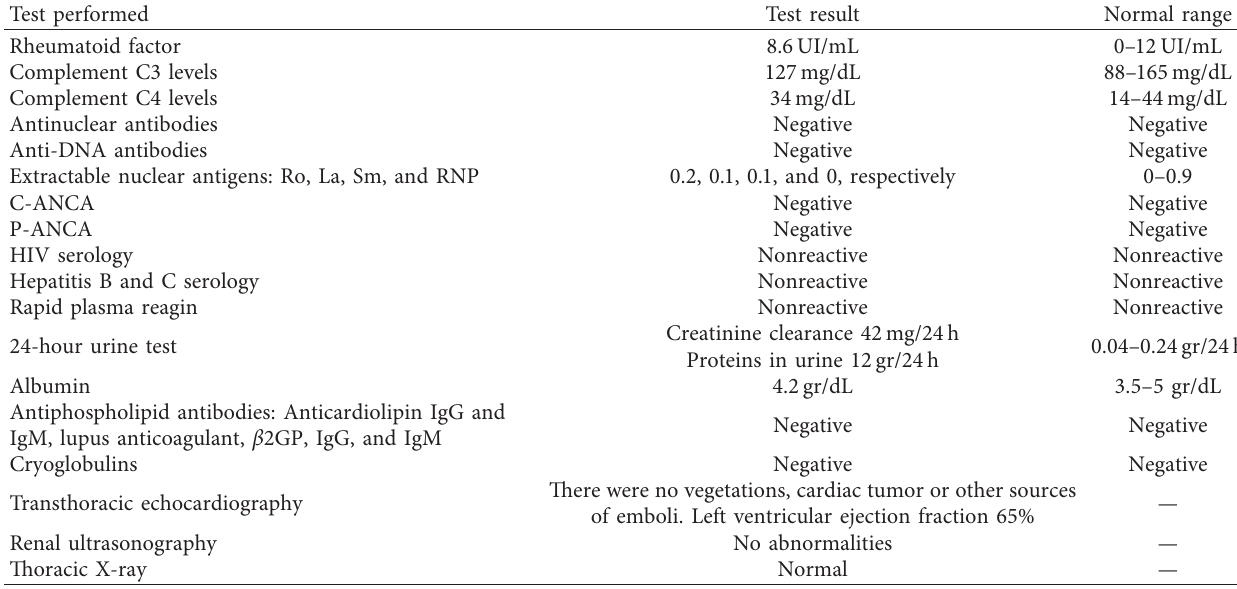
Figure 1: Black coloration (necrosis) of the second left-foot finger at admission. Table 1: Test results of the